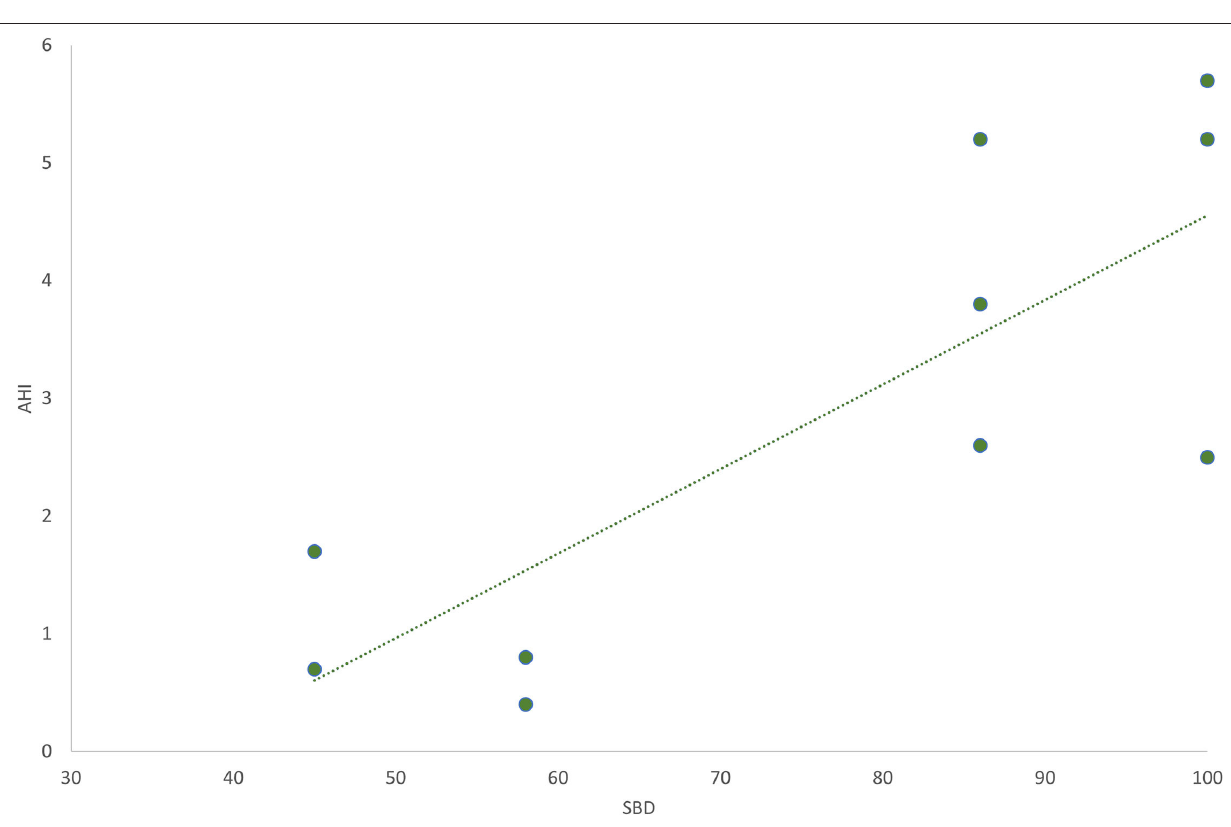
Frontiers in Neurology |